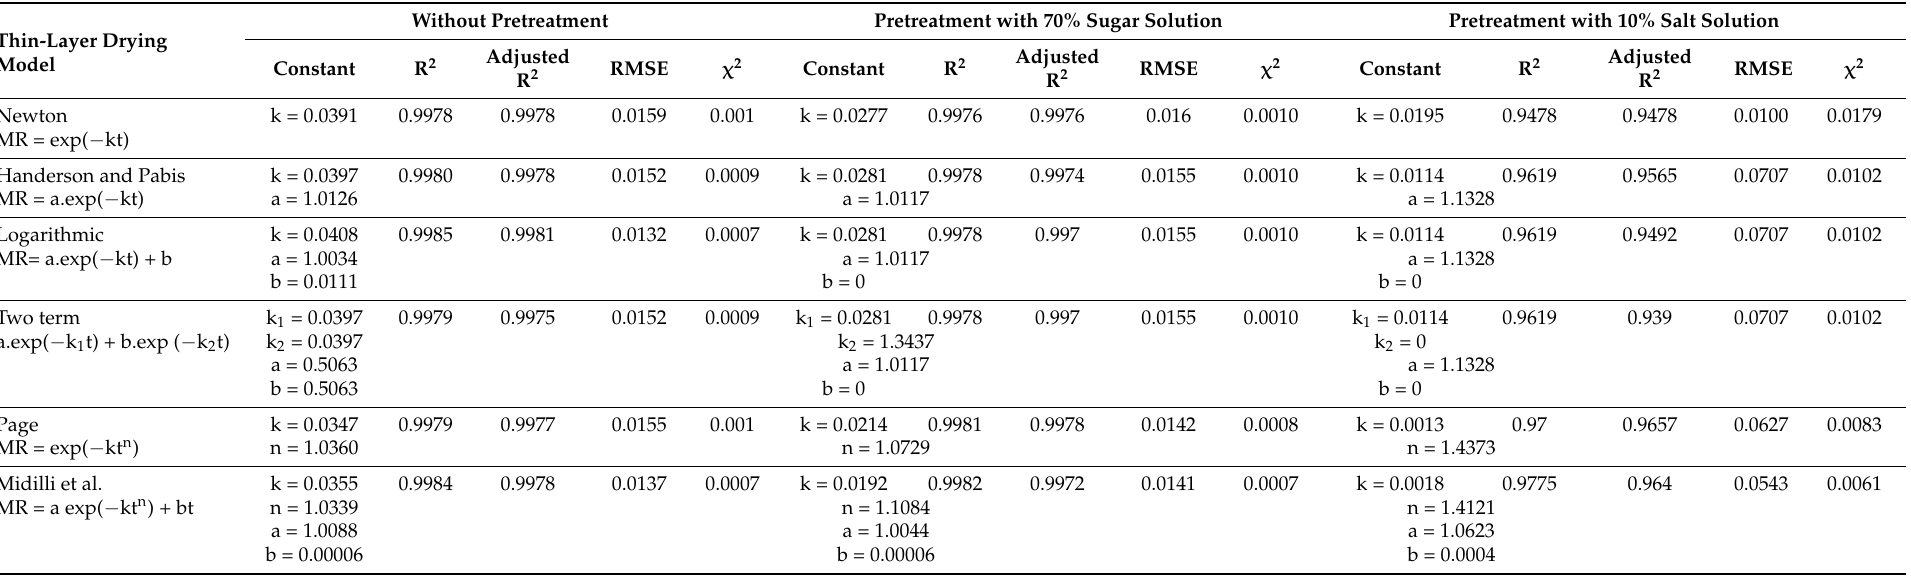
Table 2. Six thin-layer drying kinetic models and their constants for the goodness of